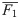
Proportion of relative errors, measured by F1¯, per estimation procedure and aggregated over all 138 datasets.Small errors (< 5%) are in blue, moderate ([5, 30]%) in green, and large errors (> 30%) in red.